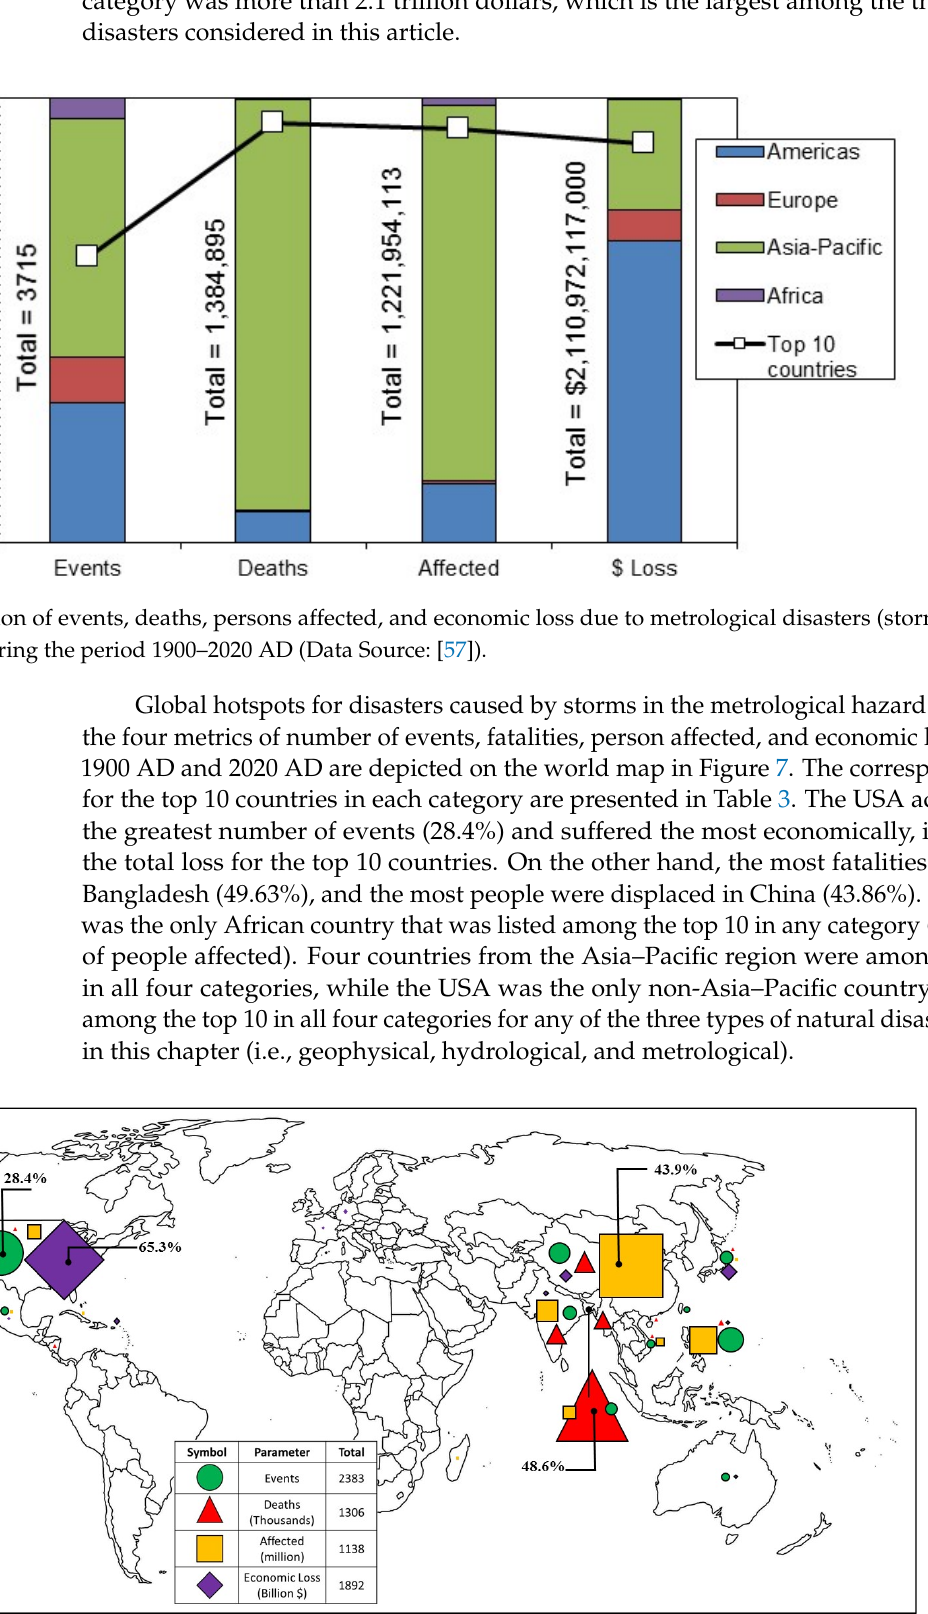
1111 Figure 5. Global hotspots for hydrological disasters based on data for the top 10 countries in each category from 1900 to 2020 AD (Data Source: [57]). 5.3. Meteorological Disasters Disasters caused by a meteorological hazard can be due to convective storms, extra- tropical storms, tropical storms, extreme temperature, and fog. In this article, only the ef- fect of disasters caused by storms is discussed. Figure 6 presents the distribution of these storm events in various regions of the world for the period of 1900 to 2020 AD in terms of fatalities, persons affected, and the associated economic loss. Again, more than 50% of the events and more than 90% of the social cost in terms of lives lost and person affected were in the Asia–Pacific region. However, the lion’s share of economic loss was suffered by the